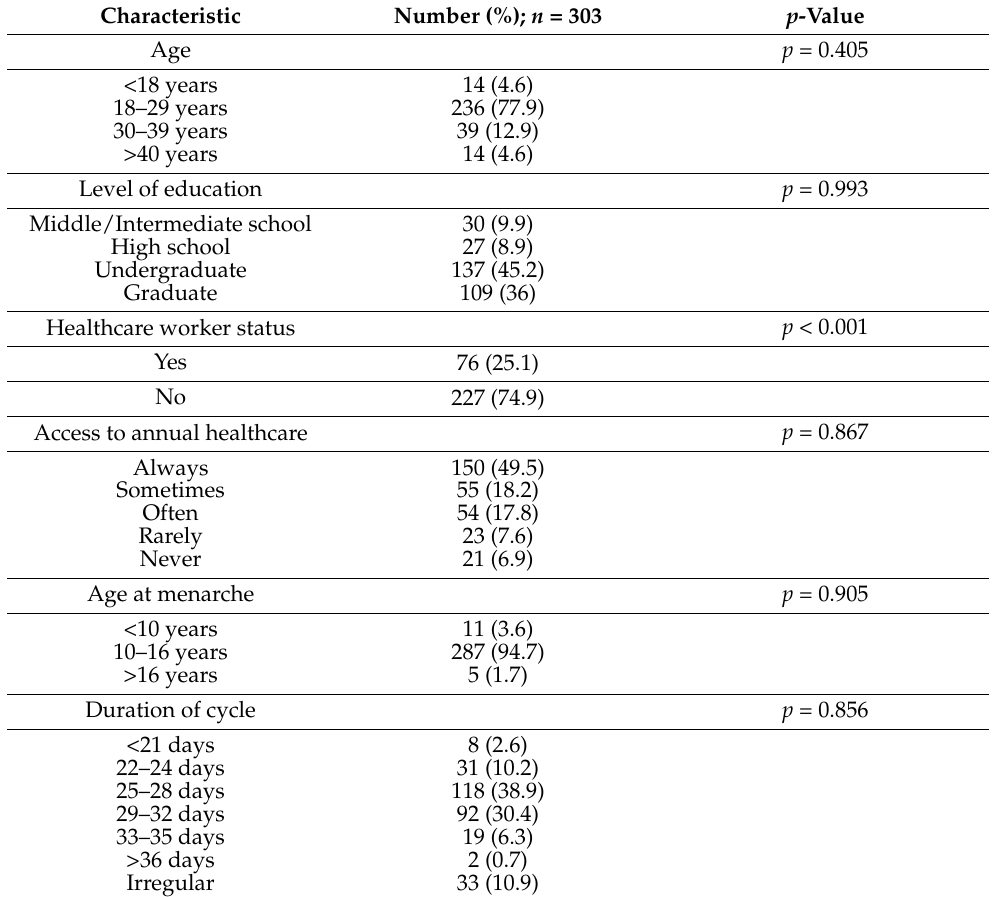
Table 2. Sample characteristics ( n =